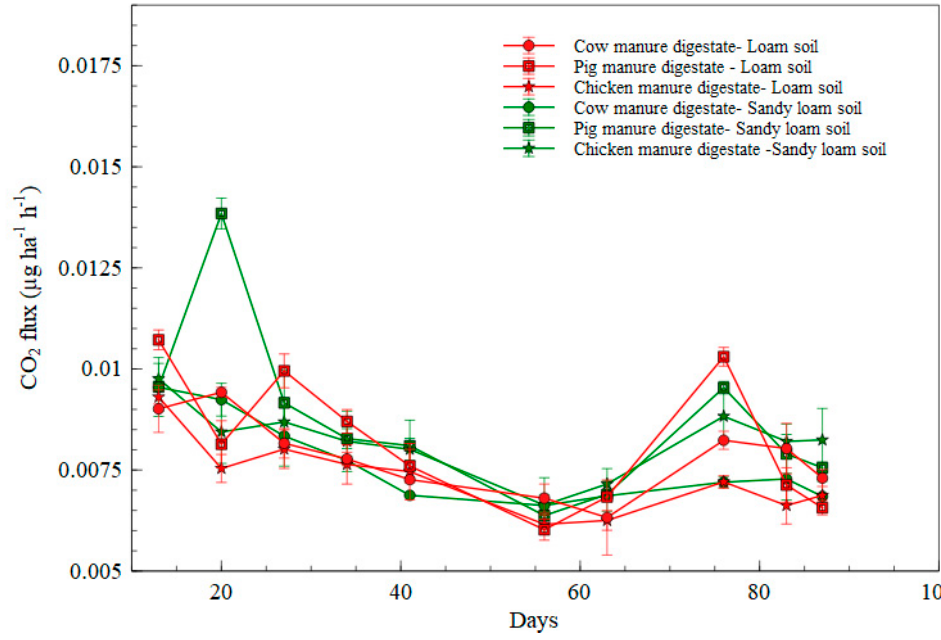
Figure 3. CO 2 emission flux for digestate treatments in loam and sandy loam soil.